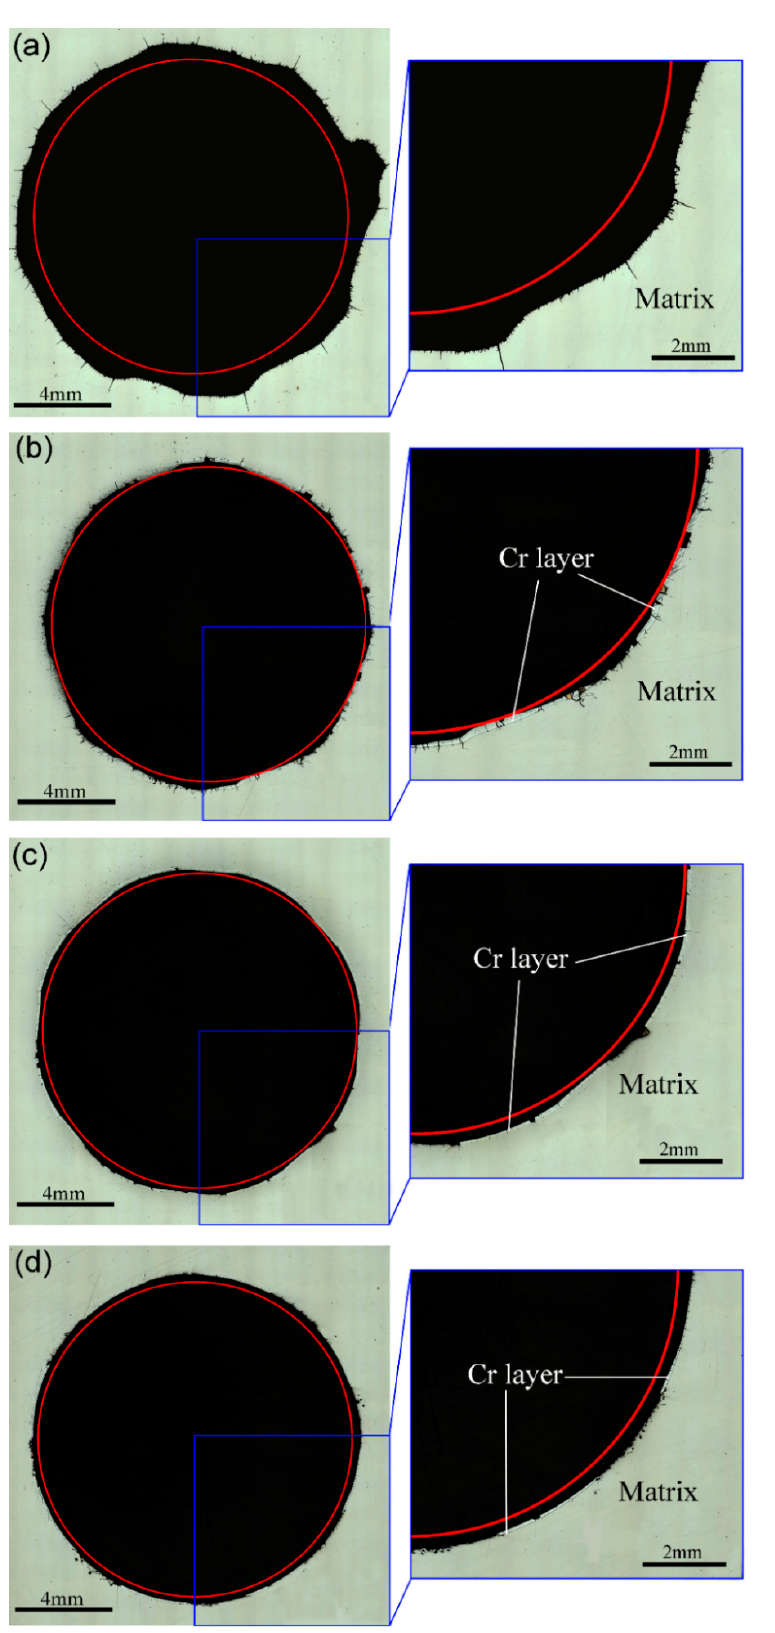
Figure 3. Cross-sectional morphologies of the samples taken by 3D intelligent hyperfield microscopy (3DIHM): ( a ) MG1; ( b ) MG3; ( c ) MG5; and ( d ) MG7.